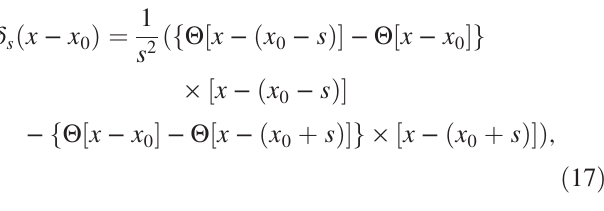
is achieved, with s ≪ a being the width of the triangle.